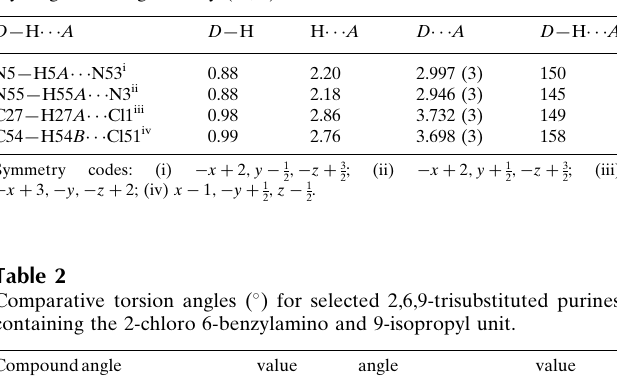
Hydrogen-bond geometry (A˚ , (cid:1) ).